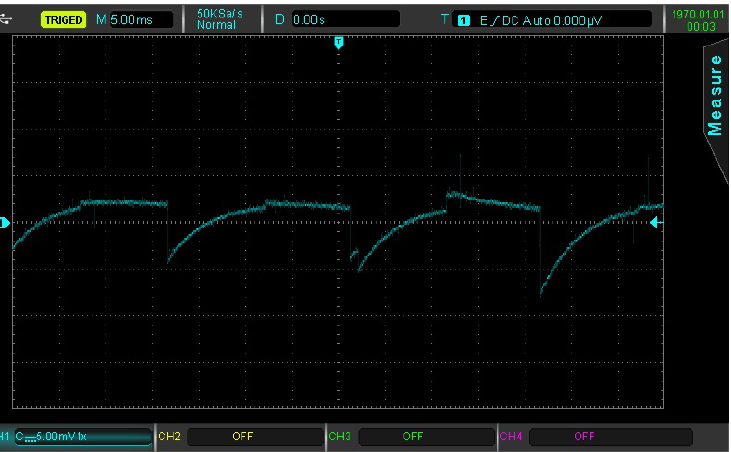
Figure 8. Detected signal above the corona inception voltage. The signal resembles that due to external corona discharges.